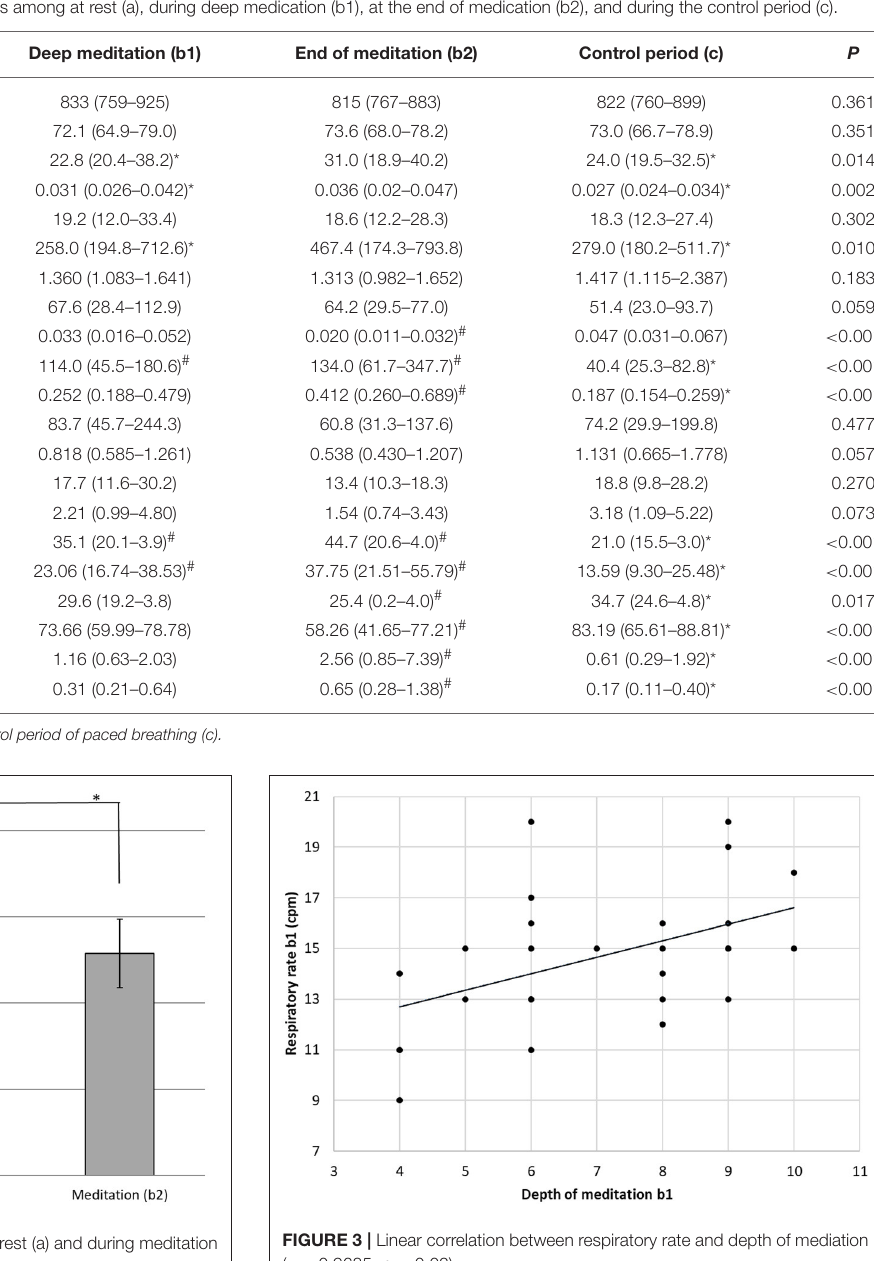
FIGURE 2 | Means and SD Respiratory rythm at rest (a) and during meditation (b1) (b2). i * p = 0.02; ** p < 10 − 5 .